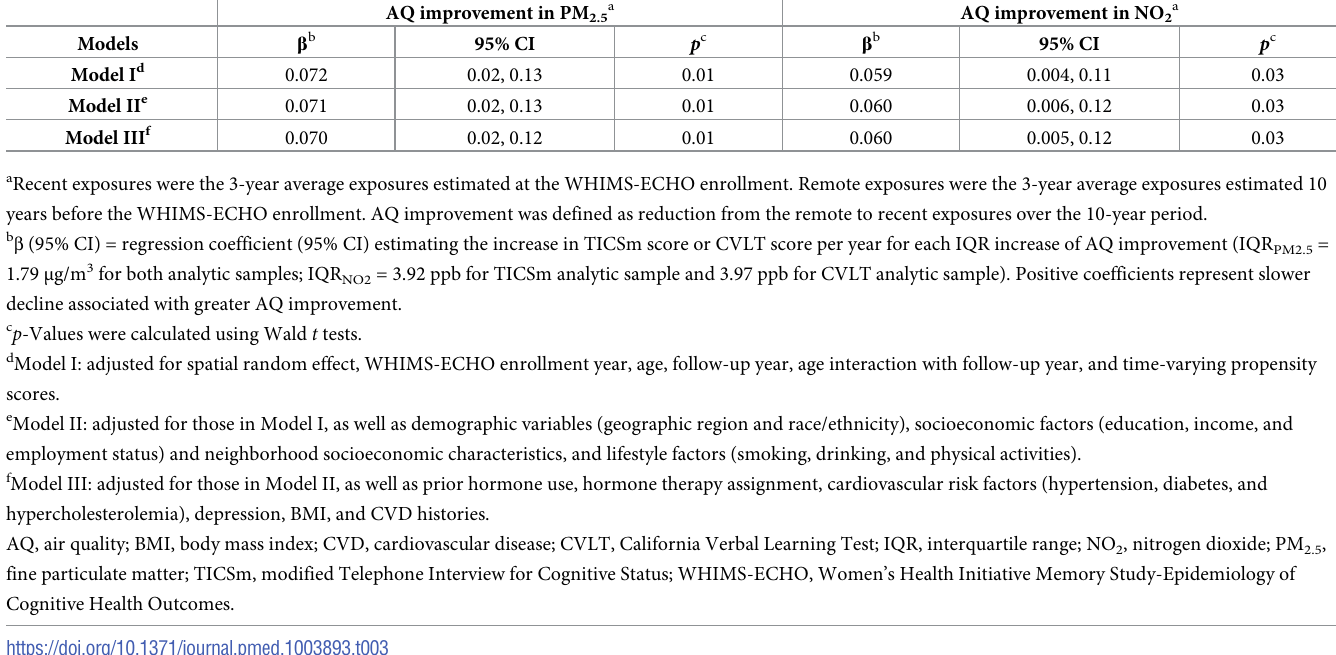
(B) Associations with declines in episodic memory ( N =